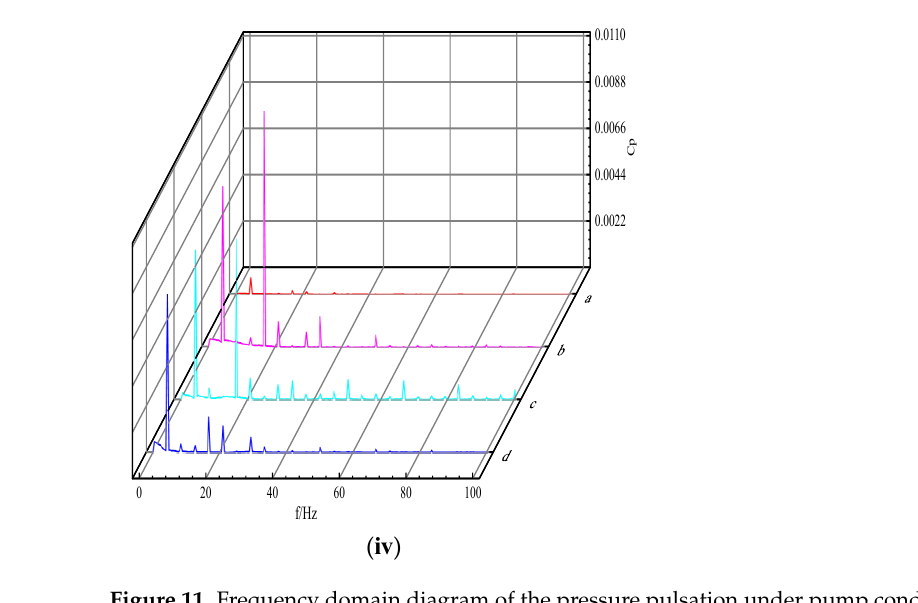
Figure 11. Frequency domain diagram of the pressure pulsation under pump condition. ( i ) 0.6Q; ( ii ) 0.8Q; ( iii ) 1.0Q; ( iv ) 1.2Q.